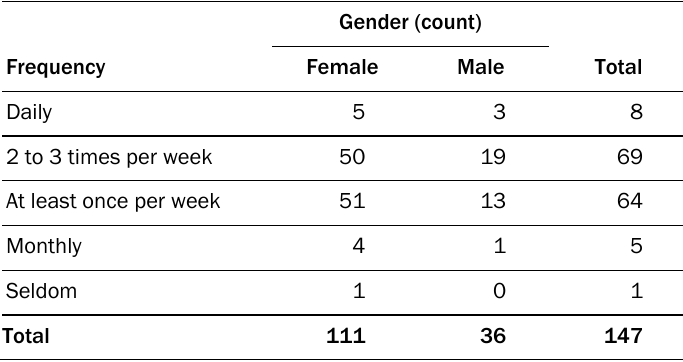
Table 3. Frequency of Purchase of Cowpea Leaves